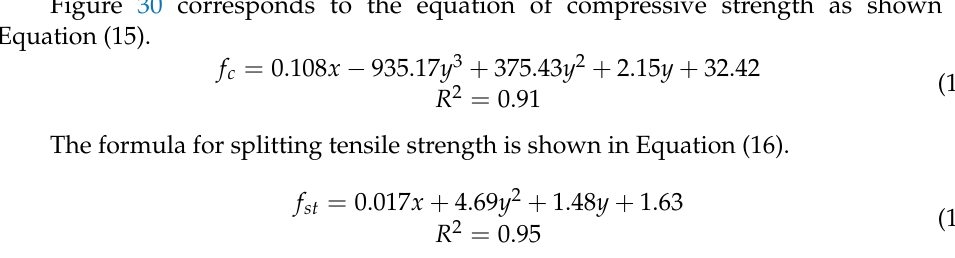
Figure 32. Non ‐ linear surface fitting results for the effect of aggregate and hybrid fiber content on the strength of LHPCC. The formula for splitting tensile strength is shown in Equation (16). Figure 30 corresponds to the equation of compressive strength as shown in Equation (15).